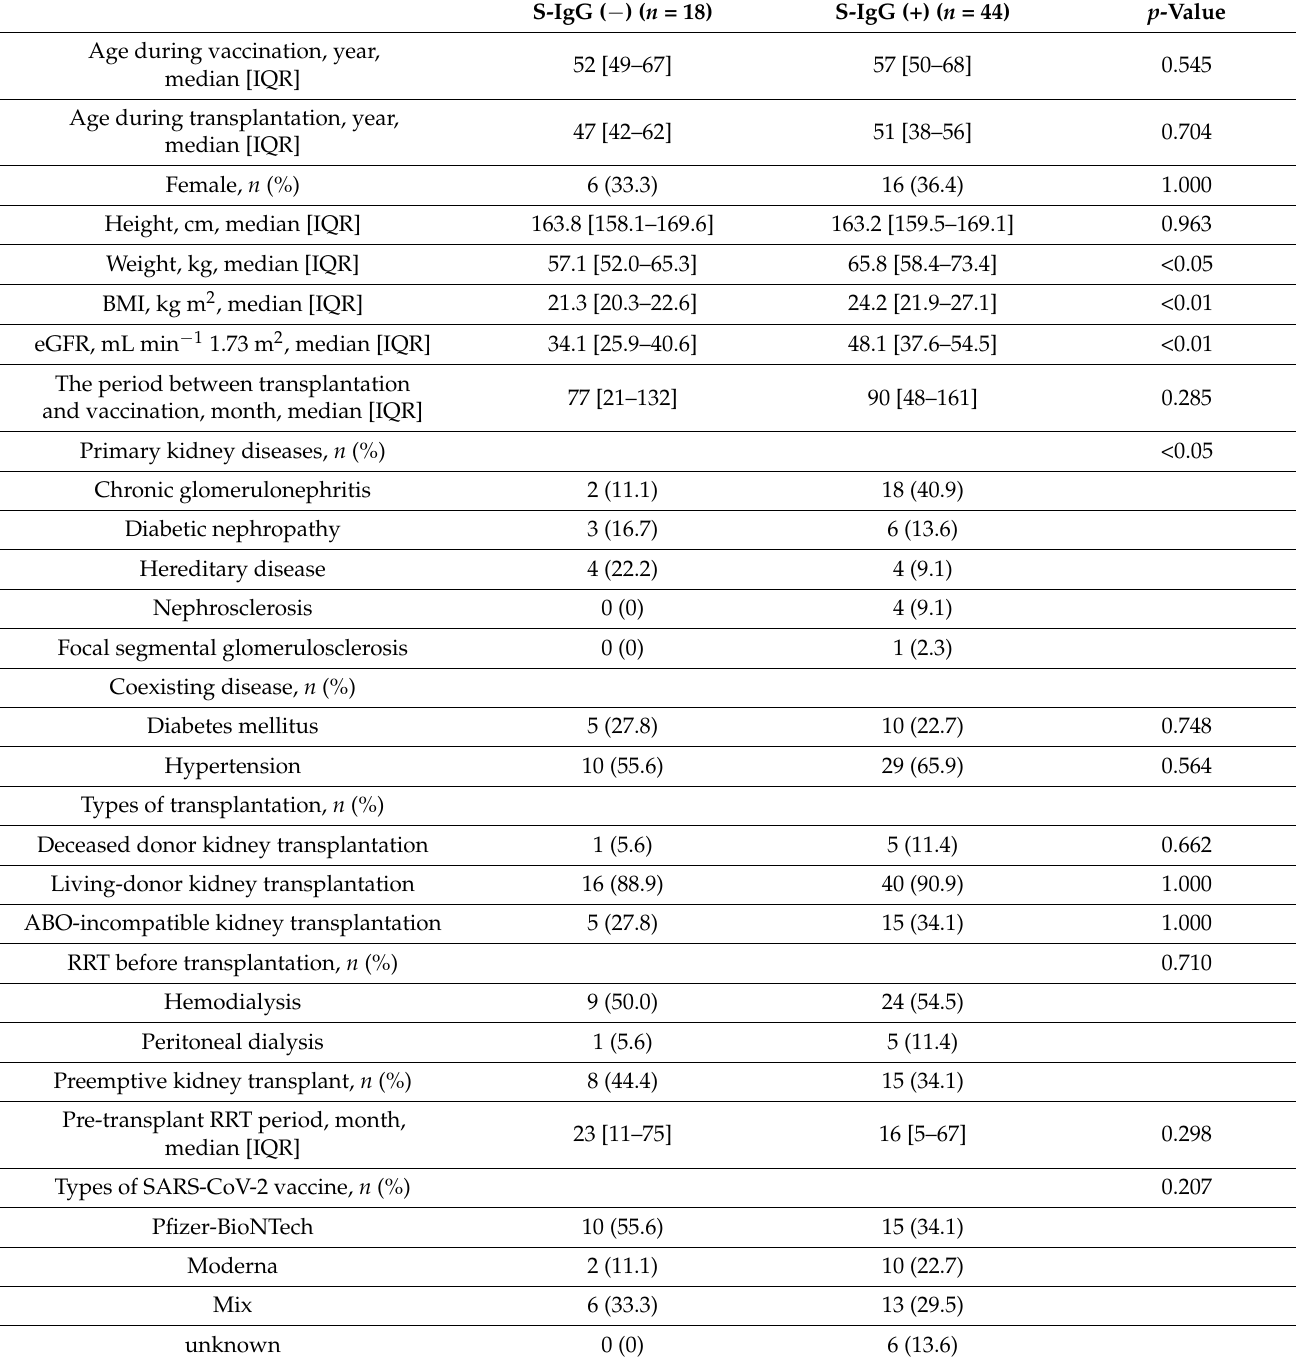
Table 2. Comparison between antibody-acquired and -nonacquired groups after the third